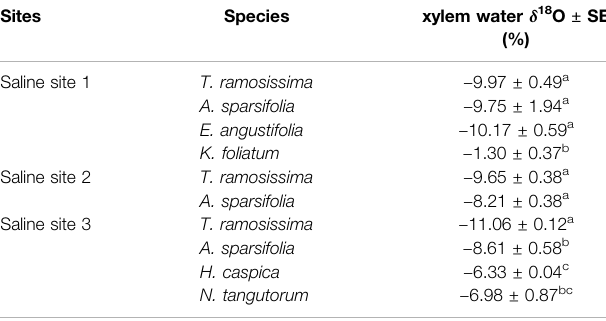
TABLE 2 | The δ 18 O values of plant xylem water in the three saline site s.